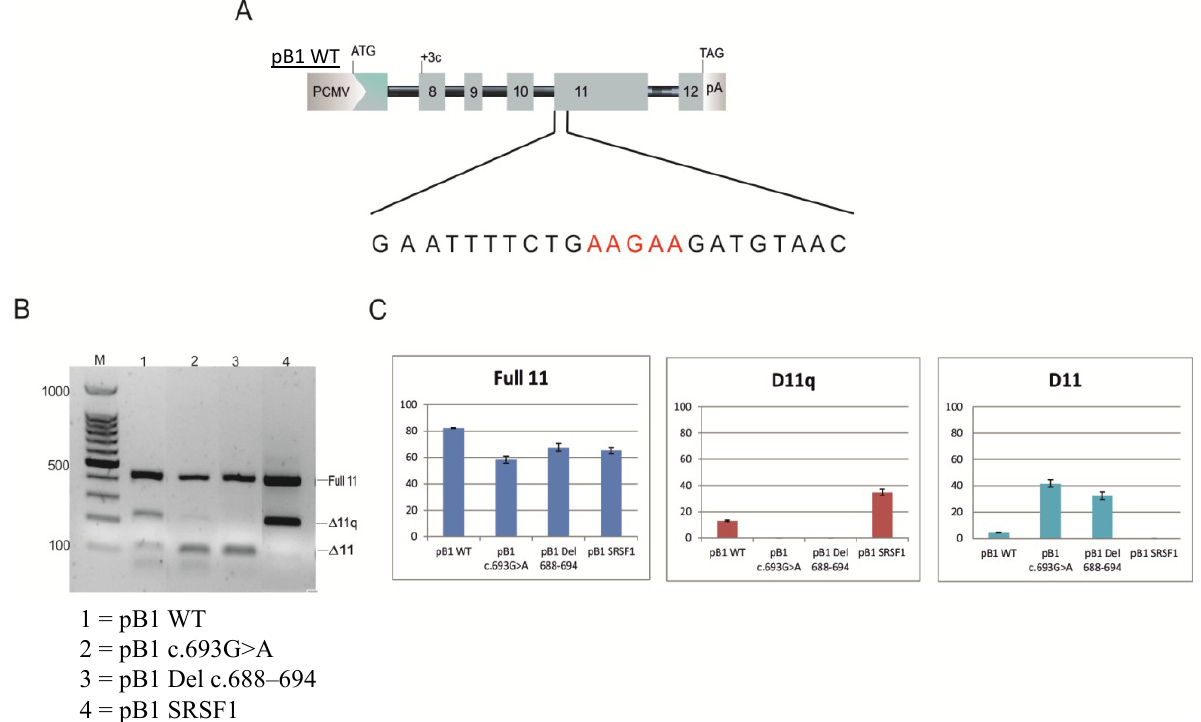
Figure 6. Minigene carrying the deletion c.688–c.694 and the minigene pBSRSF1. ( A ) The figure shows the minigene pB1 WT with the sequence AAGAA (represented in red), which has been replaced in the pB1 SRSF1 minigene; ( B ) The splicing product for the pB1WT minigene ( Lane 1 ), the minigene carrying the mutation c.693G>A ( Lane 2 ), the pB1 minigene with the deletion of the region between c.688 to c.694 ( Lane 3 ) and the minigene pB1 SRSF1 ( Lane 4 ). On the right of the gel is a schematic representation of the three splicing isoforms corresponding to each of the three bands: the full 11, the Δ11q and the Δ11 isoform. M is the 100-bp DNA ladder marker; and ( C ) The histogram shows the percentage (%) of the Full 11, Δ11q and Δ11 isoforms, respectively, calculated against the total expression of the three isoforms. The intensity of the each band was calculated using Image